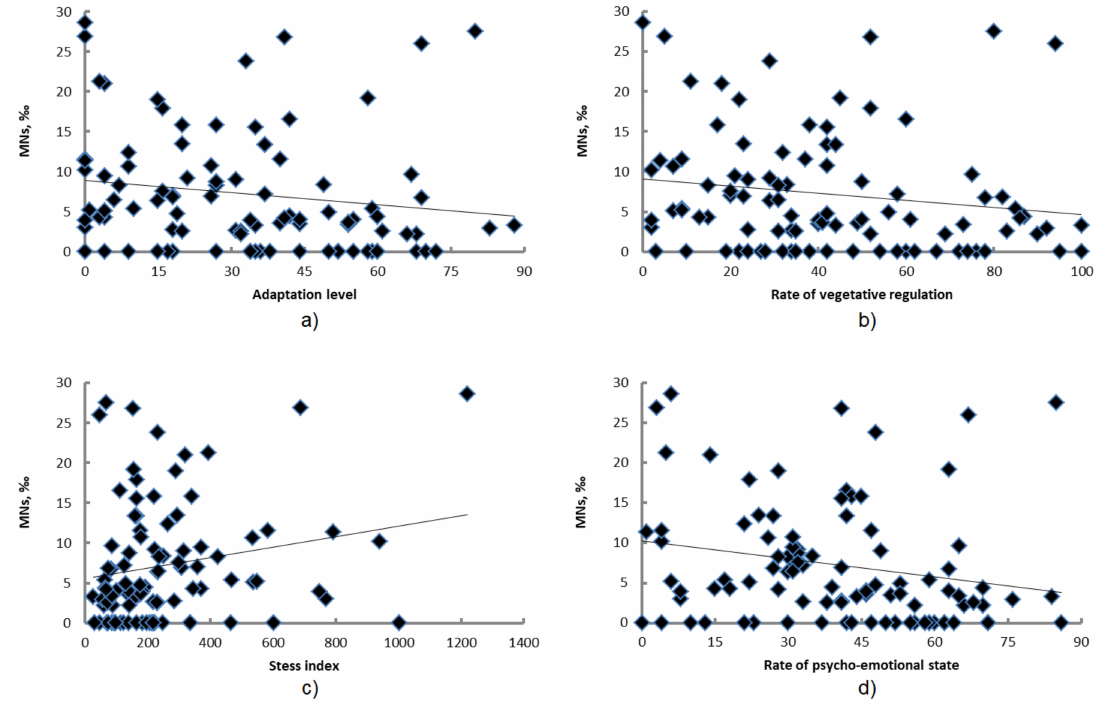
Figure 2. Relationships between the frequency of cells with micronuclei (MN) and the physiological state of the organism in miners older than 30 years: ( a ) level of body adaptation; ( b ) rate of vegetative regulation; ( c ) stress index; ( d ) psycho-emotional